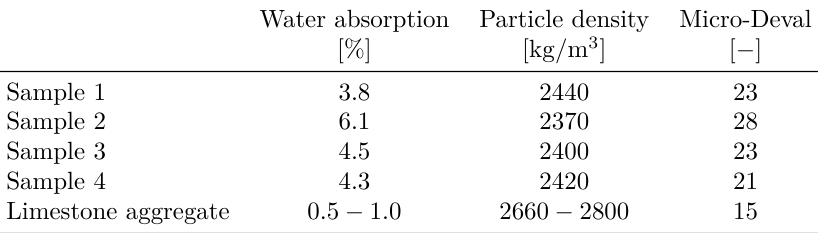
Table 1. Characterization of the treated aggregate